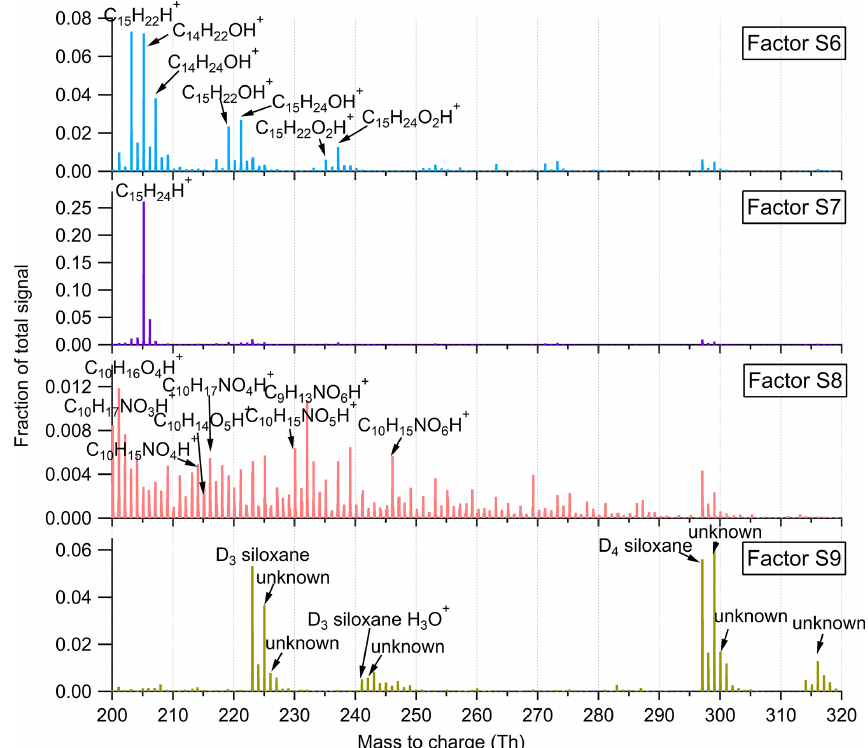
Figure 9. Mass profiles of the four factors resolved in the high-mass range at the SMEAR II station. The fingerprint peaks are labeled in the mass spectra.